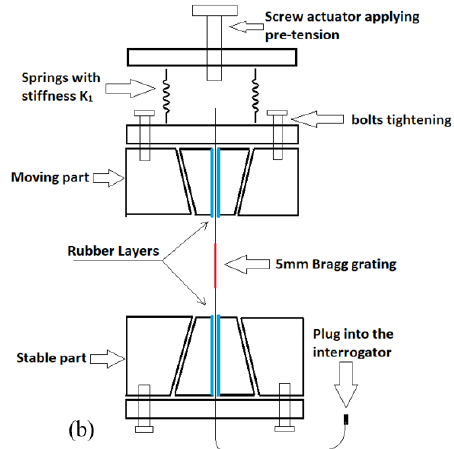
Figure 3. ( a ) Front view of the test rig sitting on the shaker, the fibre Bragg gratings (FBG) is mounted between the moving part and the stable part. ( b ) A functional diagram illustrating working principle of the test rig.